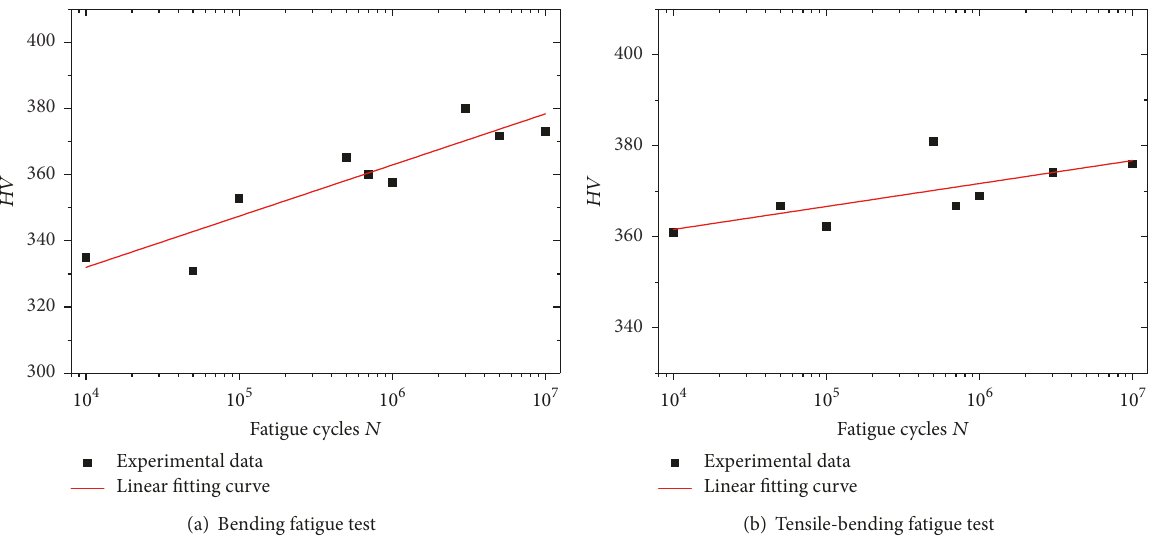
Figure 16: Hardness of two groups of